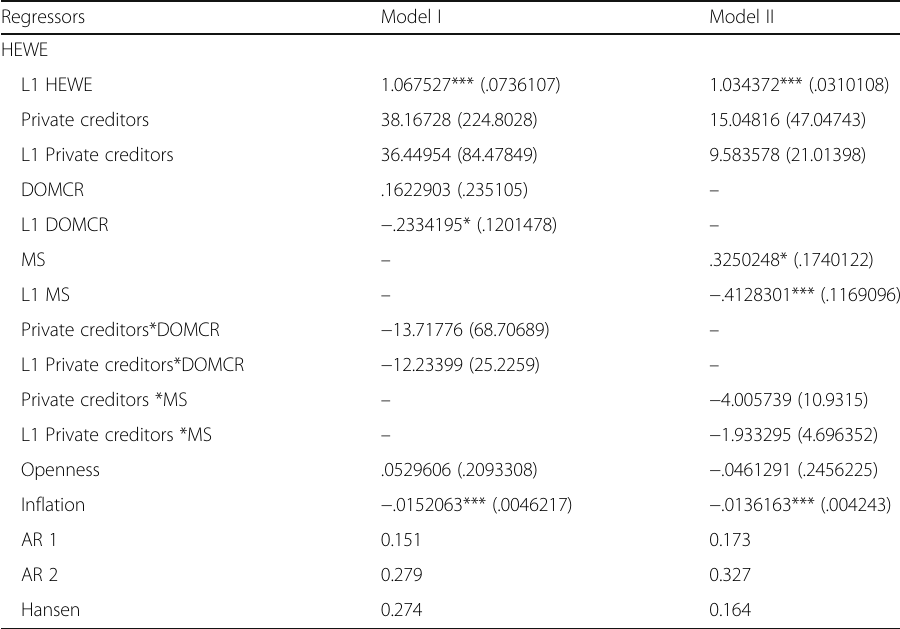
Table 13 Dynamic panel data estimation, one-step system GMM: interaction effect of Private Cred- itors and financial development on HEWE